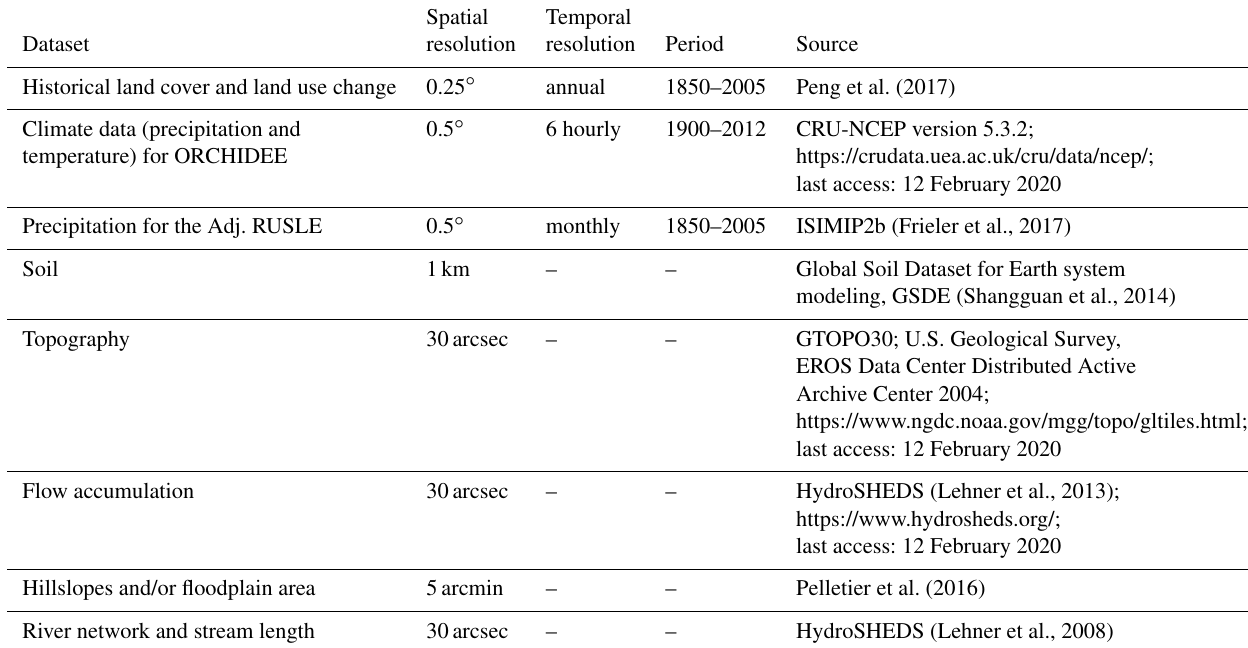
Table 1. Model input